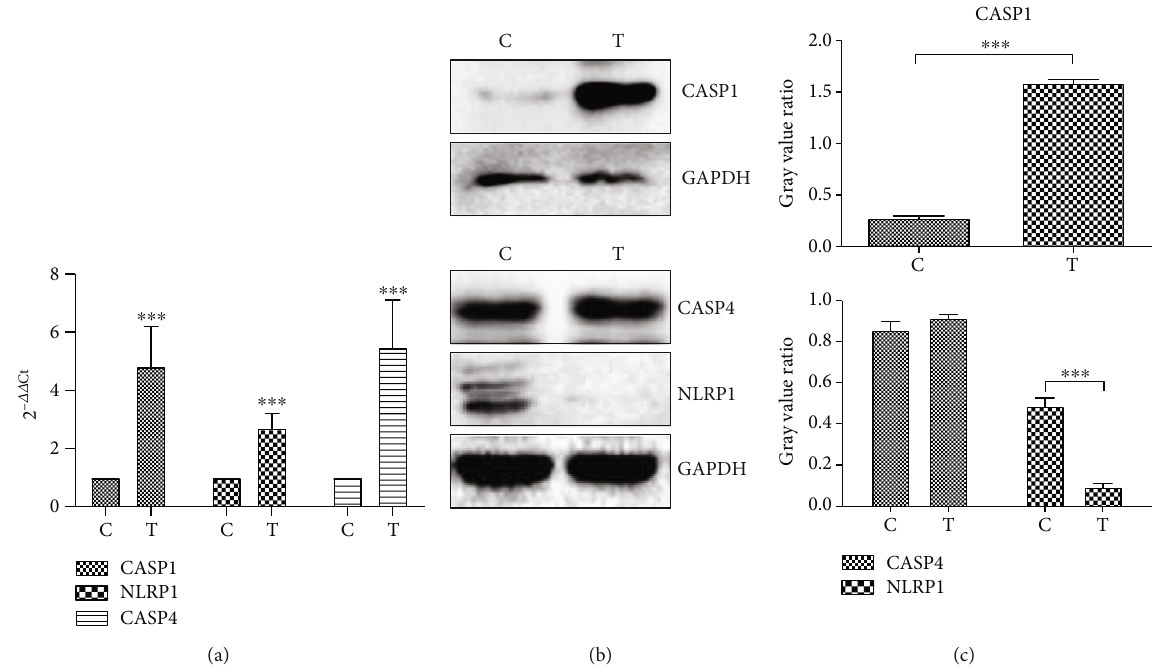
Figure 1: Detection of pyroptosis-related genes. (a) The results of q-PCR. Data are presented as Ct (2 - △△ Ct ) relative to control. Data are presented as mean ± S : D : , n = 3 . (b) The results of western blotting. (c) The gray value ratio of western blotting results. C: control group, MCF7 cells cultured in the hUCMSC medium; T: treatment group, MCF7 cells cultured in hUCMSC-CM medium. ∗ P < 0 : 05 , ∗∗ P < 0 : 01 , and ∗∗∗ P < 0 : 001 2 : 89 ± 0 : 79 , respectively) than those in the control cells ( P < 0 : 001 ; Figure 1(a)). These results were consistent with our previous RNA sequencing results.